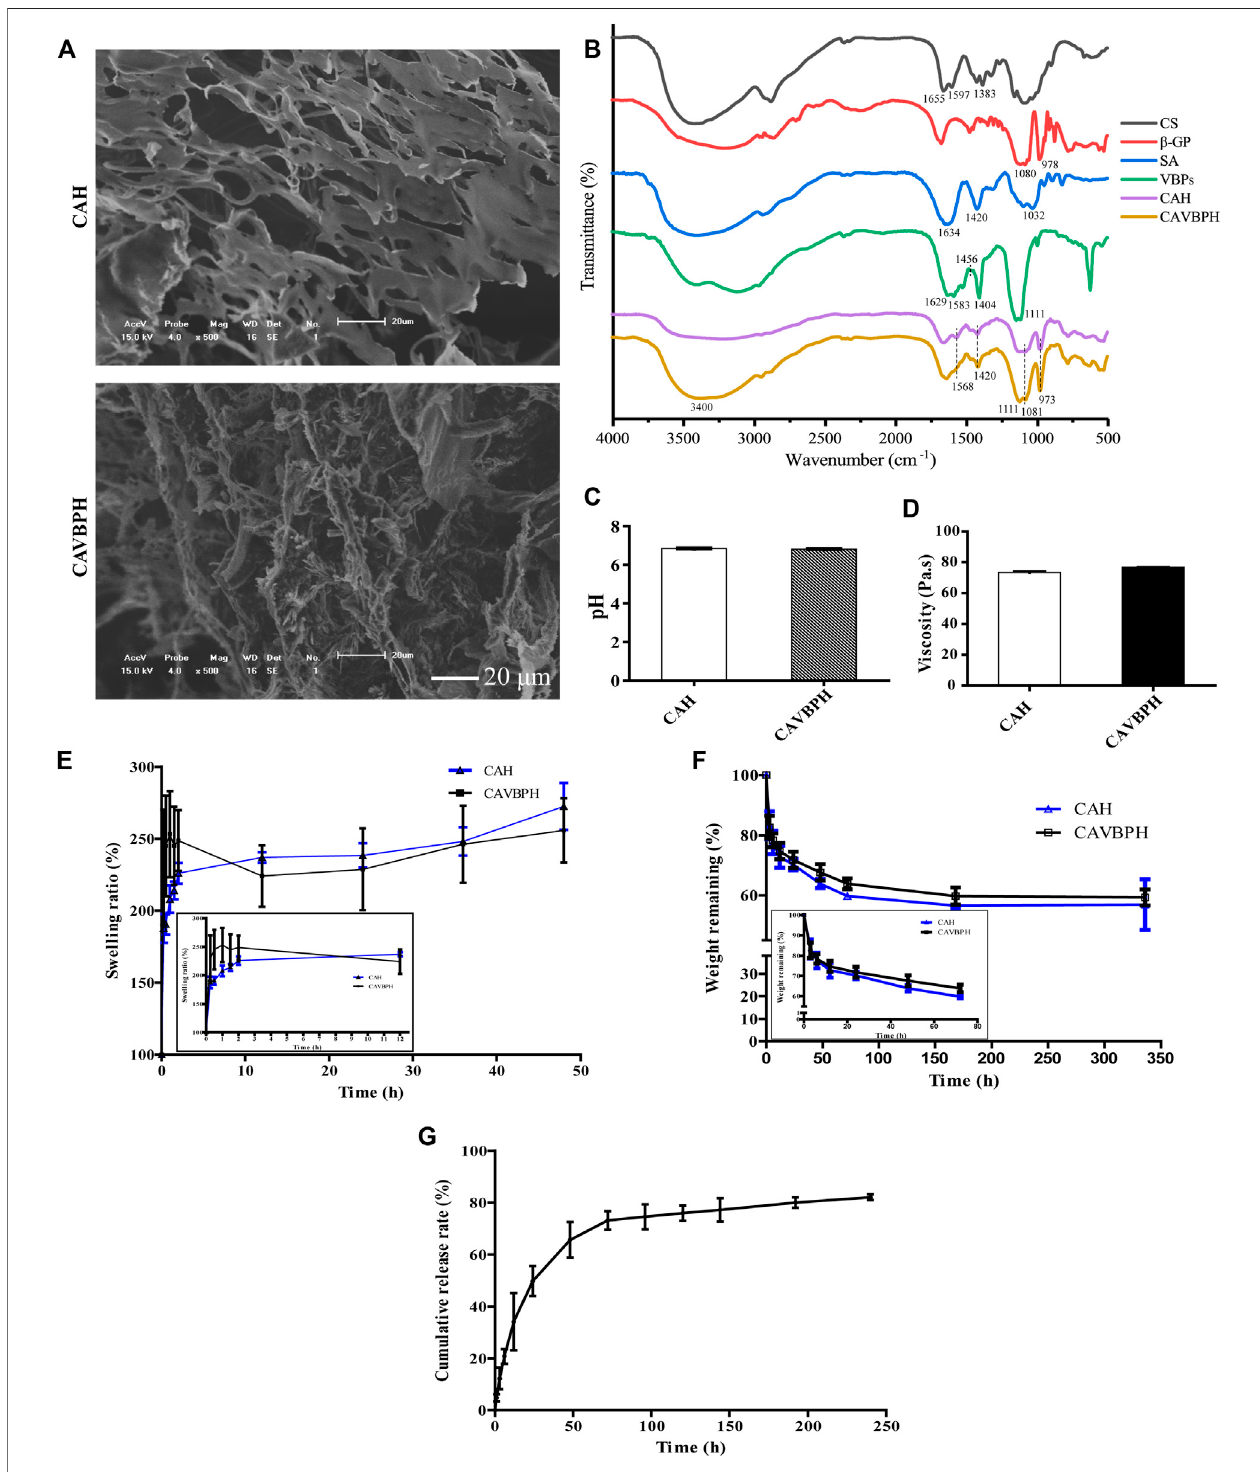
FIGURE1| Invitro performanceevaluationofhydrogels. (A) SEMmicrograph(scalebar=20 μ m). (B) Infrared(IR)spectroscopy. (C) pHtest. (D) Viscositytest. (E) Swelling test. (F) Biodegradation test. (G) In vitro release pro fi le of VBPs.